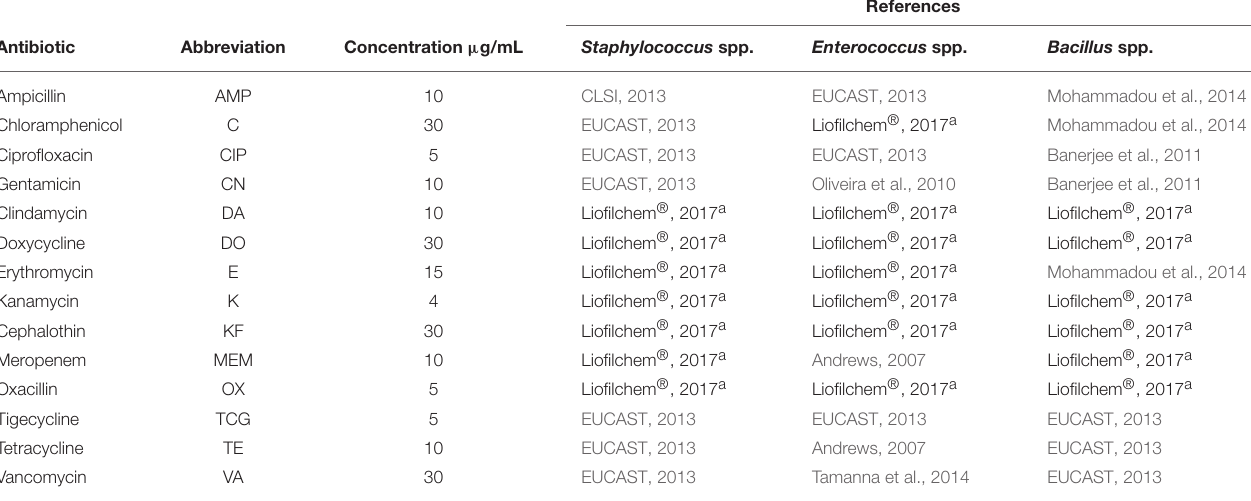
TABLE 2 | Antibiotic disc diffusion